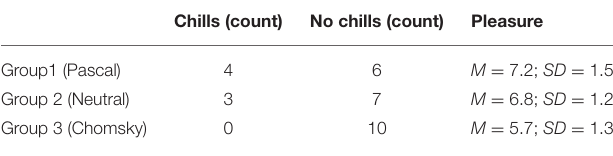
TABLE 1 | Distribution of chill subjects within priming groups and mean